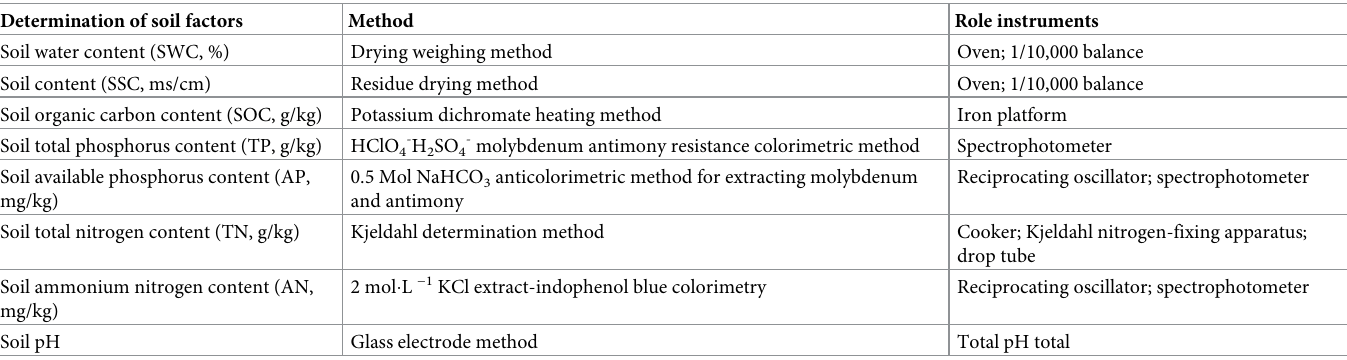
Table 1. Indicators of soil